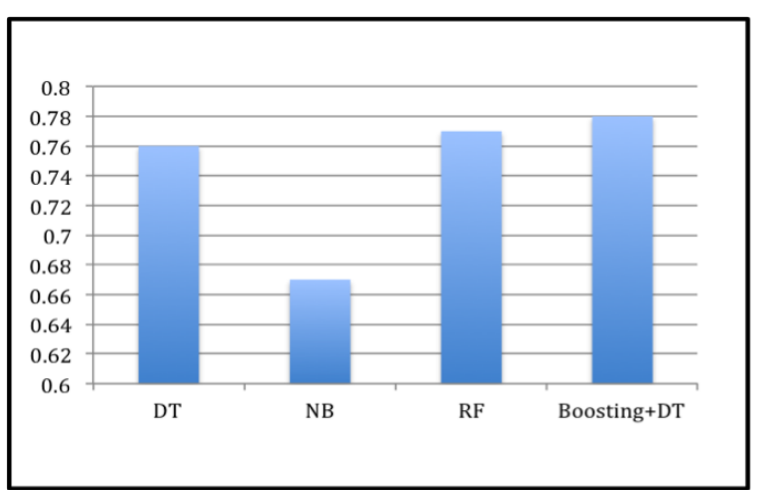
Figure 15. The Recall of DM techniques and ensemble